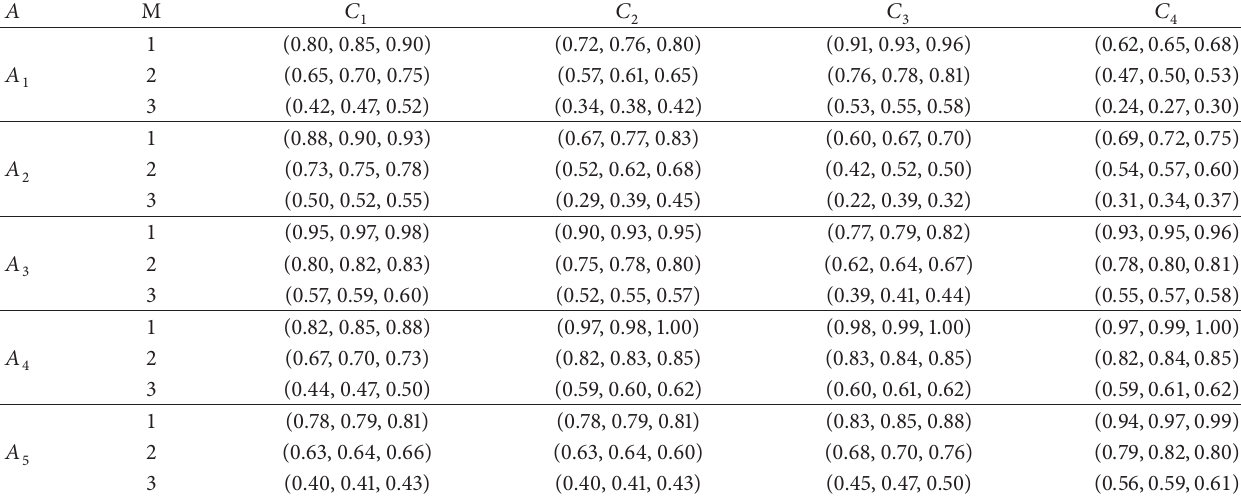
Table 5: The TFNs preference vector of the three experts.